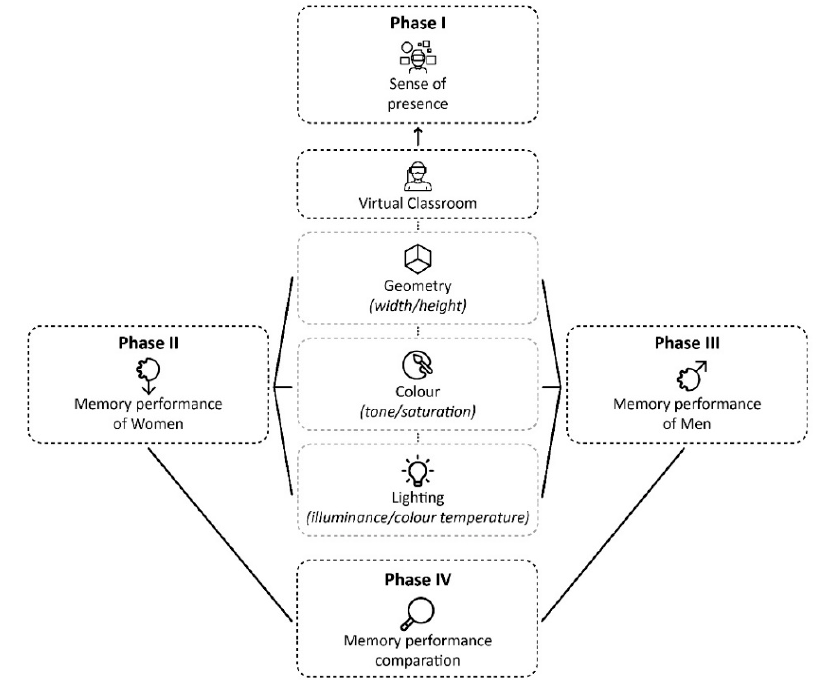
Figure 1. General methodological